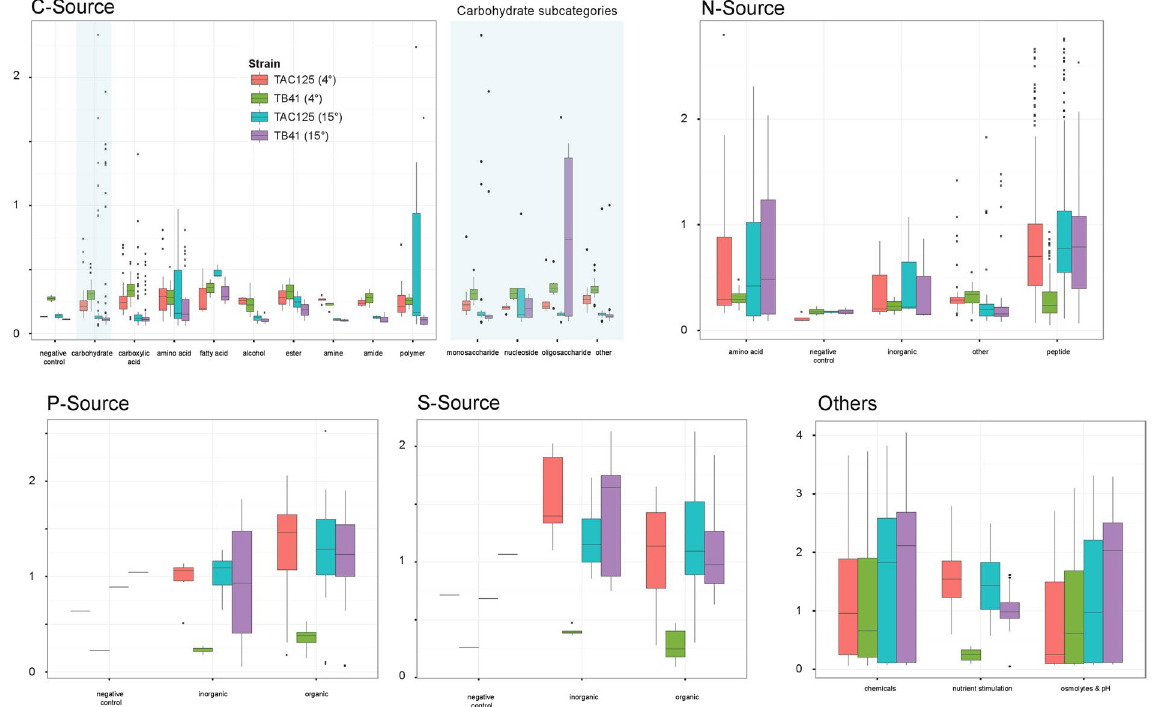
Figure 3. The utilization of carbon (C), nitrogen (N) phosphorous (P) and sulfur (S) sources under 4 °C and 15 °C. A boxplot displaying the PM 4–8 source utilization. The figures include all positive phenotypes (gray circles) for PhTAC125 and PspTB41 (at 4 °C and 15 °C). The carbohydrate group was further divided into sub- types.